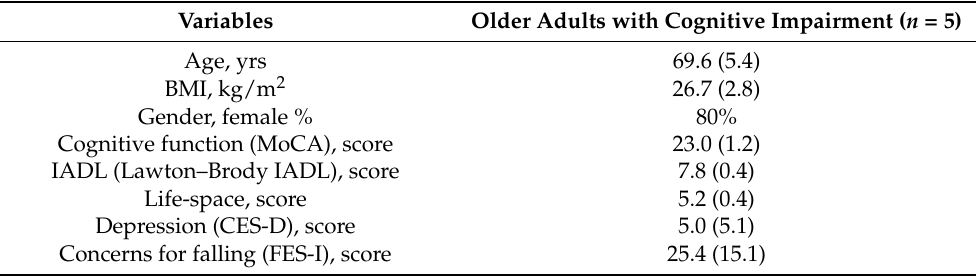
Table 2. Demographic